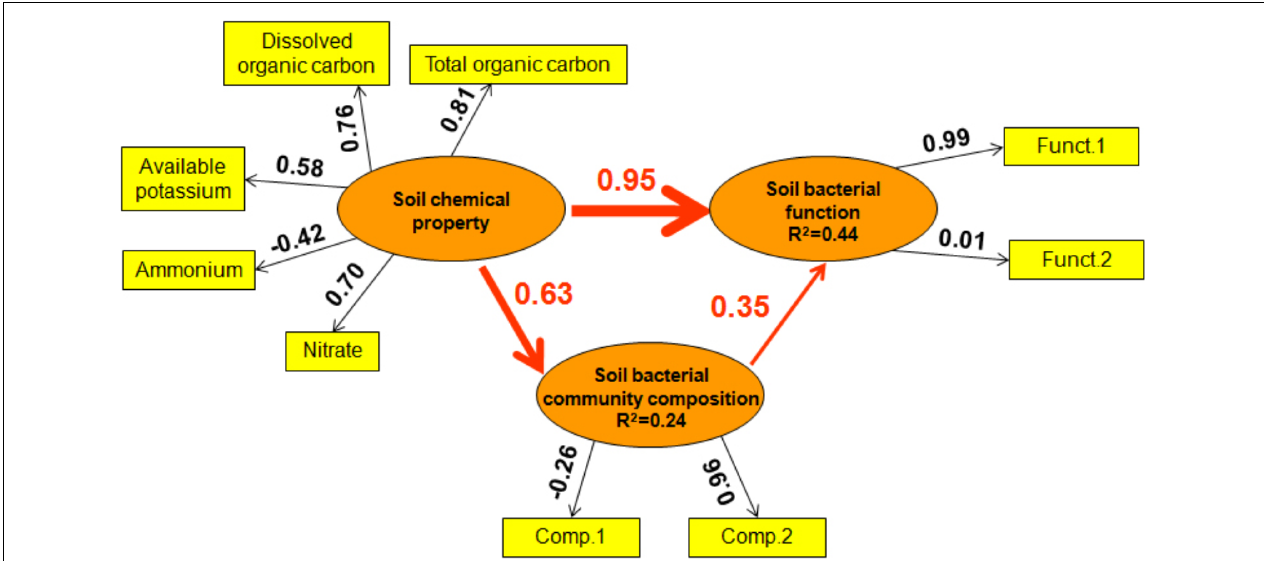
FIGURE 7 | Directed graph of the Partial Least Squares Path Model (PLS-PM). Observed (i.e., measured) variables are represented in a rectangular form, while latent variables (i.e., constructs) are represented in an elliptical form. The loadings (the correlations between a latent variable and its observed variables) are indicated as the values in rectangles, and the path coefficients (between latent variables) and the coefficients of determination ( R 2 in ellipses) are calculated after 999 bootstraps. The Model was assessed using the Goodness of Fit (GoF) statistic, a measure of the overall prediction performance. The GoF was 0.42.